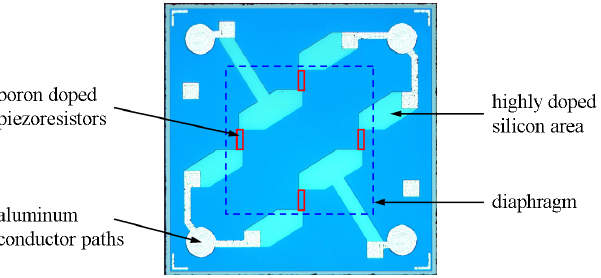
Figure 1. Pressure sensor chip with four piezoresistors intercon- nected as a Wheatstone bridge. The doping of the piezoresistors is too low to be visible in an optical microscope image. The location of the resistors is therefore indicated by red boxes. The footprint is 1 × 1mm 2 and the height